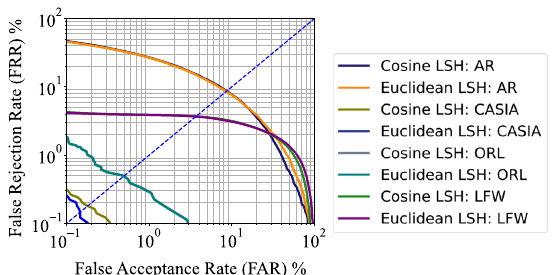
Fig. 9 ROC curves of our scheme over various databases under stolen-token scenario